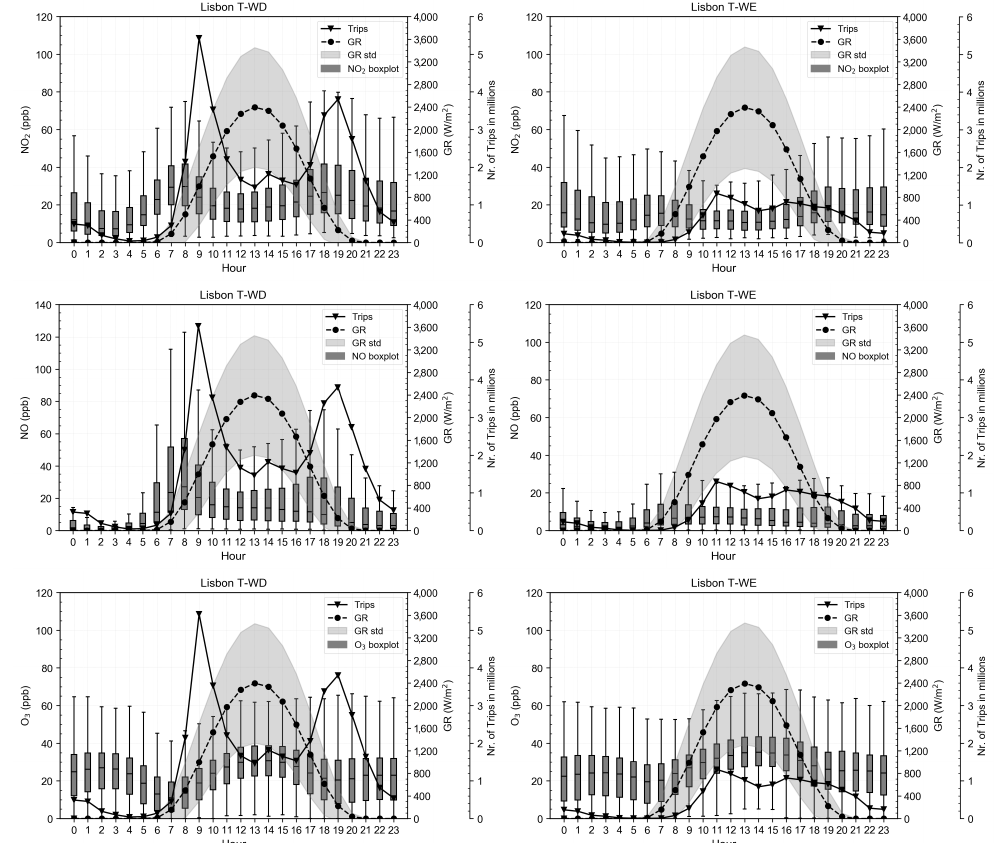
Figure 11. Mean values of all years data. Lisbon Traffic (T) AQMS comparison of WD ( left ) and WE ( right ) for NO 2 , NO, and O 3 (top to bottom